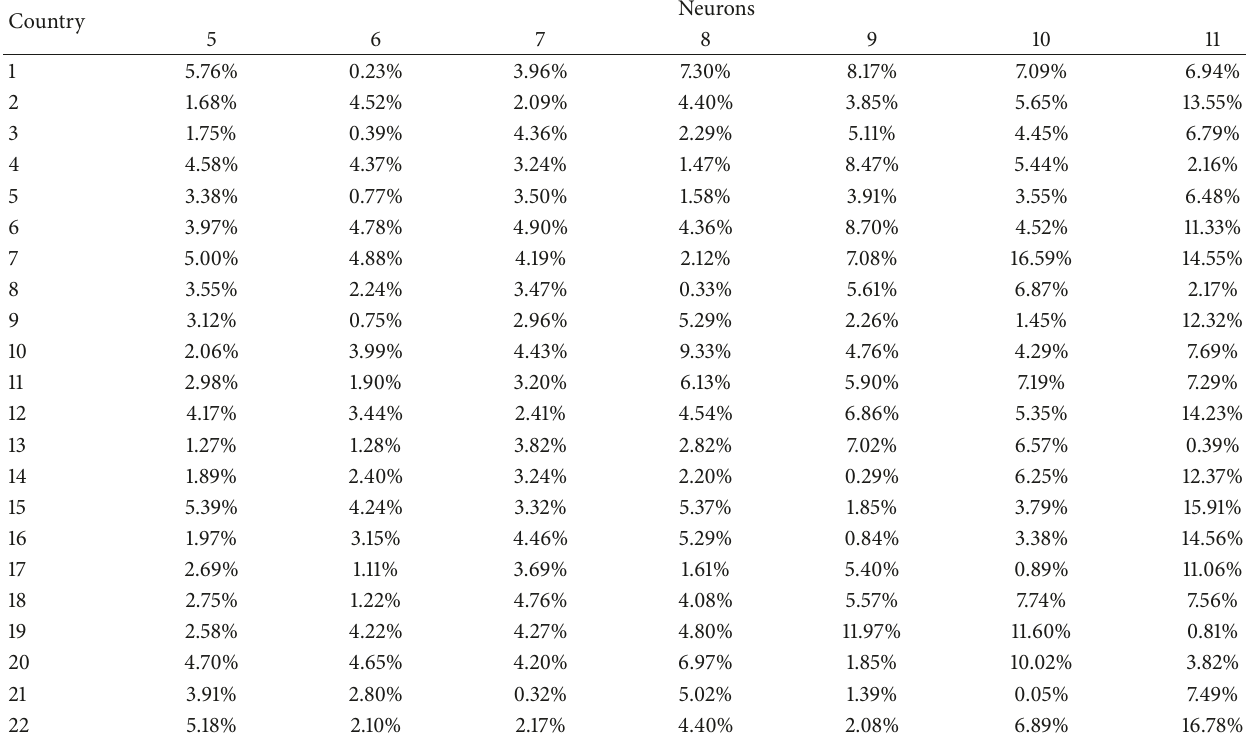
Table 4: Asian model error corresponding to the number of neurons in different hidden layers.